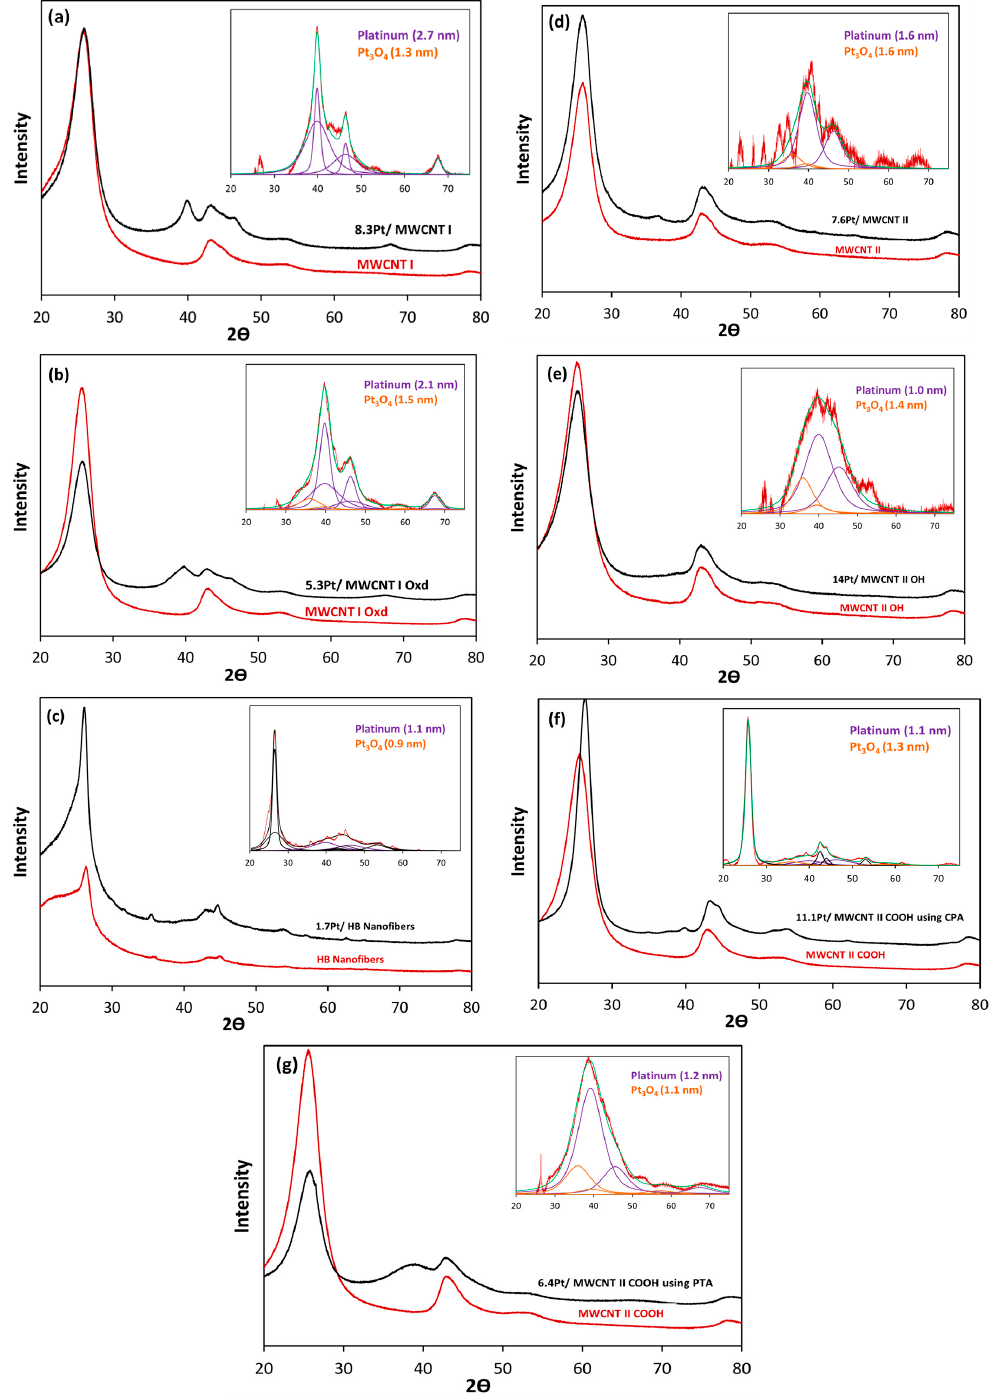
Figure 3. XRD plots with deconvolutions inset for: ( a ) MWCNT I; ( b ) MWCNT I Oxd; ( c ) HB Nanofibers; ( d ) MWCNT II; ( e ) MWCNT-II OH; and ( f ) MWCNT-II COOH using CPA and ( g ) MWCNT-II COOH using